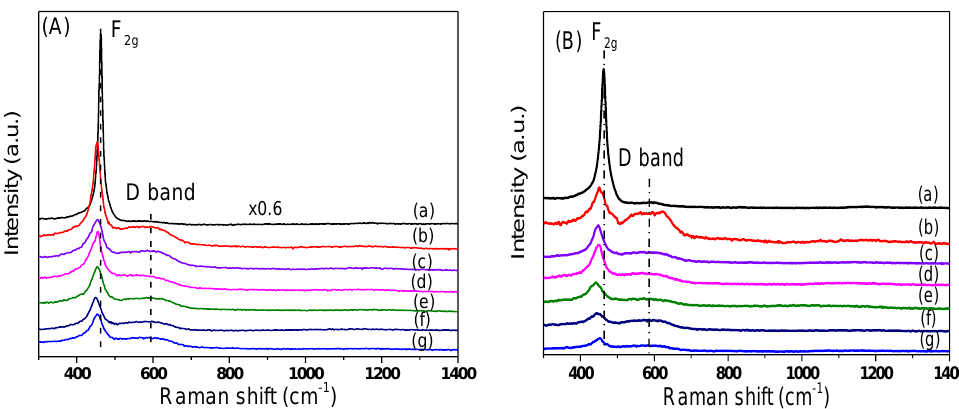
Figure 4. Raman spectra ( A ) xNiO/CeO 2 precursors and ( B ) reduced xNi/CeO 2 catalysts (a) CeO 2 , (b) 5Ni/CeO 2 , (c) 10Ni/CeO 2 , (d) 15Ni/CeO 2 , (e) 17.5Ni/CeO 2 , (f) 20Ni/CeO 2 , (g) 30Ni/CeO 2 .